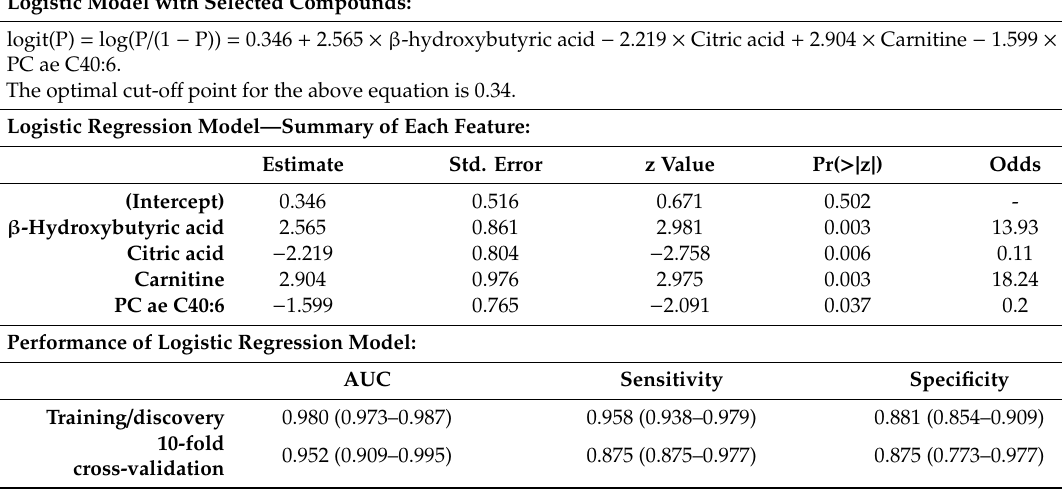
Table 4. Logistic regression based optimal model for stage II NSCLC detection: metabolites only.